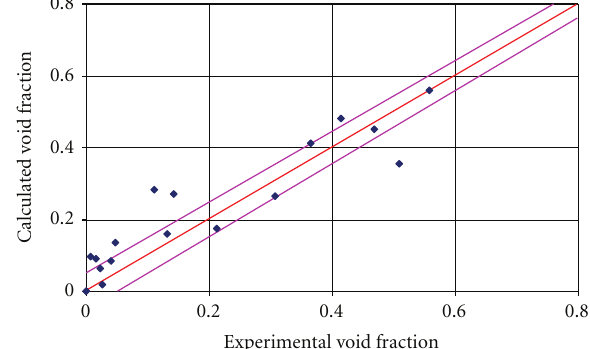
Figure 3: Comparison between calculated and measured void frac- tion for subchannel type S3.